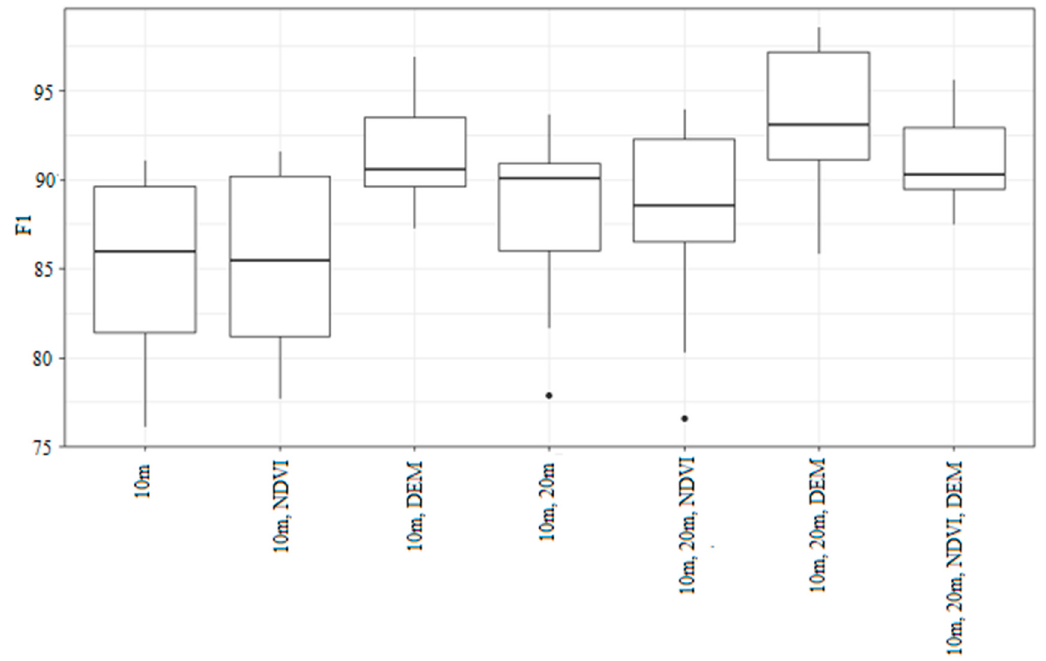
Table 1. The accuracy of the forest cover classification based on the combination of Sentinel-2 bands at 10 m and 20 m spatial resolution and DEM, * indicates image used for the parametrisation of the classification model; UA: user’s accuracy, PA: producer’s accuracy.